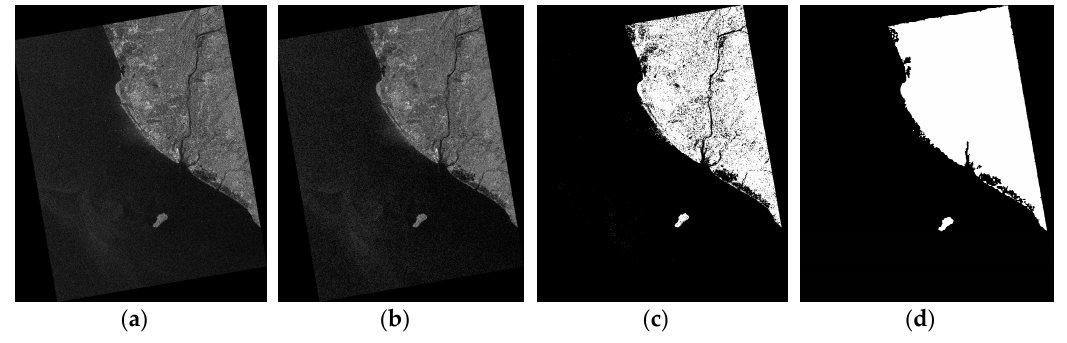
Figure 10. Land masking results of RADARSAT-1 image: ( a ) The image after downsampling; ( b ) The image after median filtering; ( c ) The image after thresholding; and ( d ) The land mask.